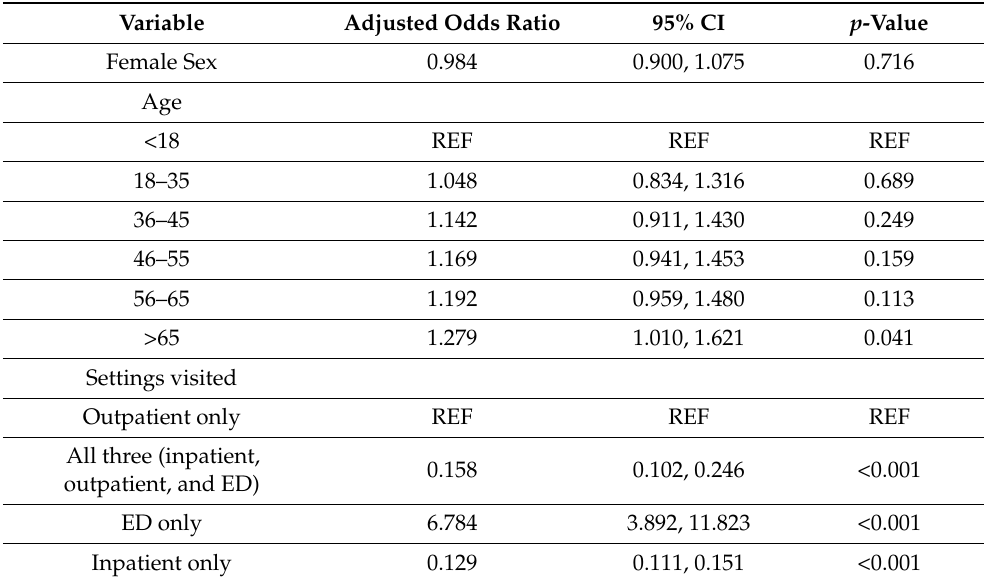
Table 3. Regression results for the likelihood of a potential missed